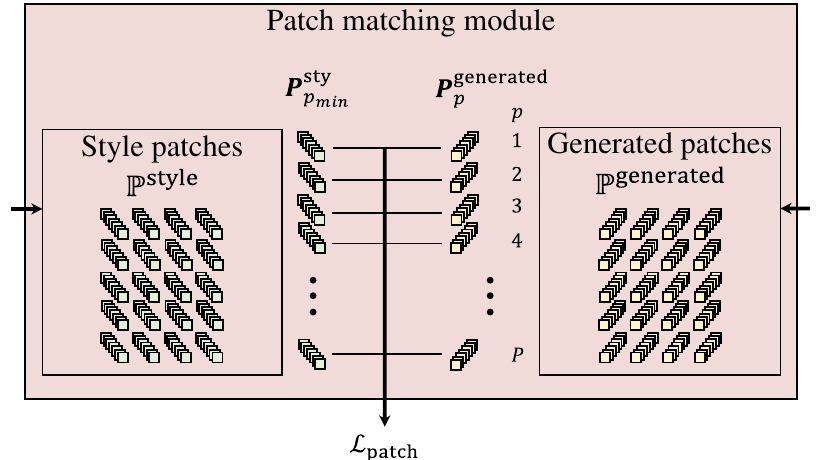
Fig 8. Patch matching module. Patches are extracted as a set of generated patches P generated and a set of style patches P style from layers conv3_1 and conv4_1 of F generated and F style , respectively. Because we extract patches from the same layers for generated and style images, the patch number is the same, P . Then, for every generated patch P generated as index, closest style patch P style with index p is found. Patch matching loss L min p min and P style . P generated p p min